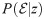
PEEV measures the average width of P(E|z) relative to P(E).PEEV is close to 0 if the widths are the same, and close to 1 if P(E|z) is, on average, much narrower that P(E). In all panels, the black line is P(E), and the coloured lines are P(E|z) for three different settings of the latent variable, z. A. For high PEEV, the conditional distributions, P(E|z), are narrow, and have very different means. B. For intermediate PEEV, the conditional distributions are broader, and their means are more similar. C. For low PEEV, the conditional distributions are very broad, and their means are very similar.